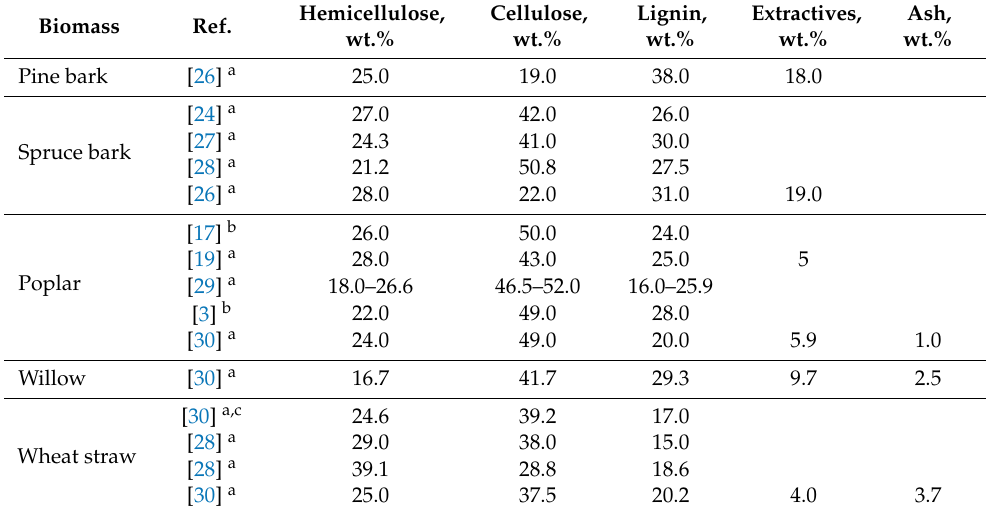
Table1. Literaturereferencesofthemainlignocellulosicfractioncompositionsrelatedtousedbiomasses.